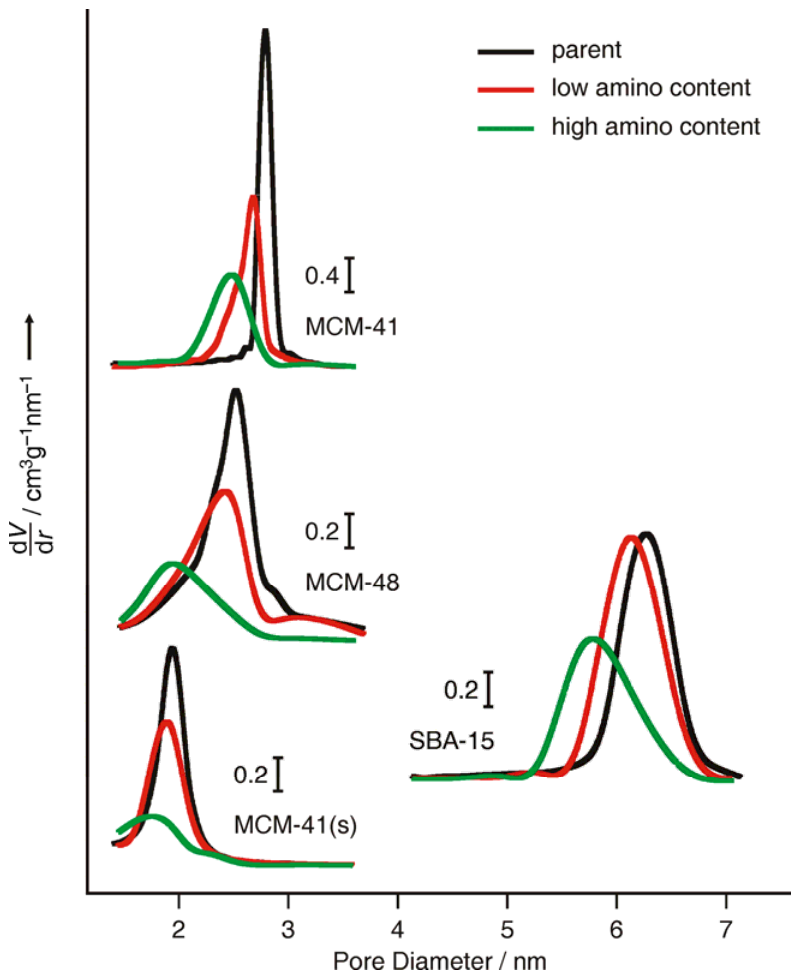
1. Pore size distributions (BJH, desorption isotherm) of parent and amino-functionalized mesoporous